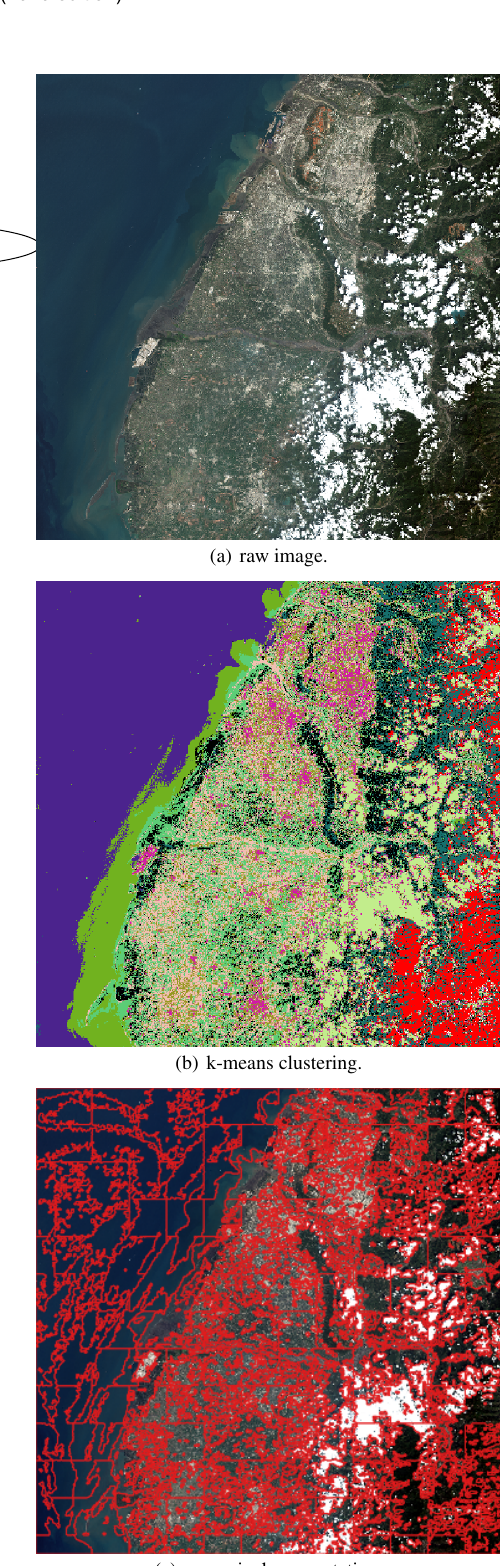
Figure 3. Labeling